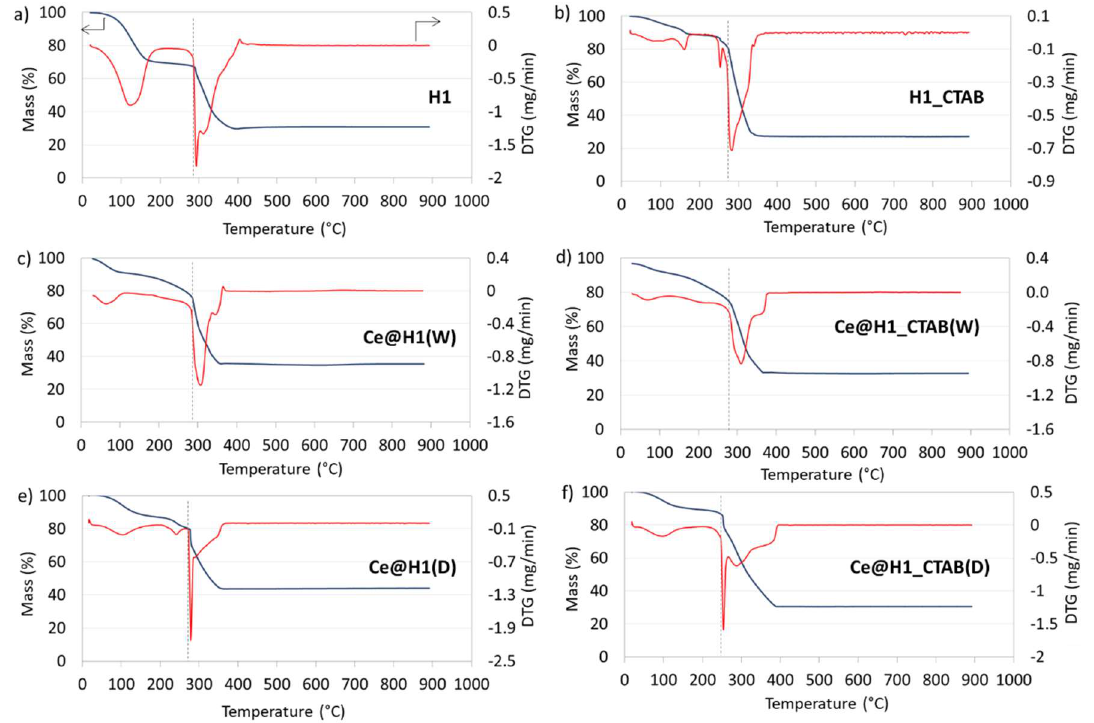
Figure 10. Mass of the sample (blue) and DTG (red) plots for HKUST-1 ( a , b ) and Ce@HKUST-1 materials (c-f). Table 3. Temperature of structure decomposition and mass loss due to combustion of BTC linker. Sample